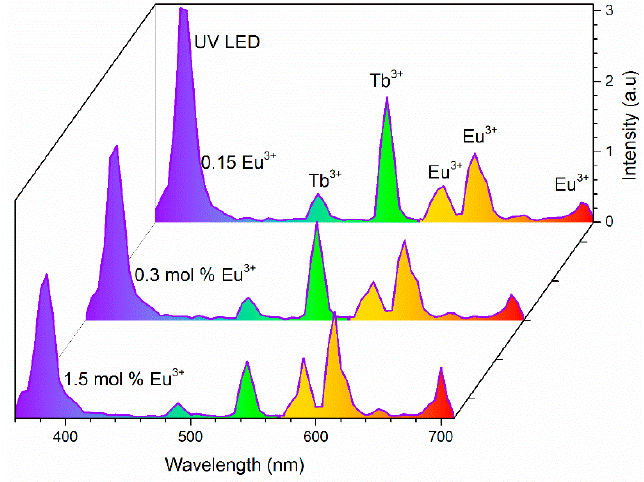
Figure 10. Electroluminescent spectra of LEDs fabricated using a 380 nm UV LED chip combined